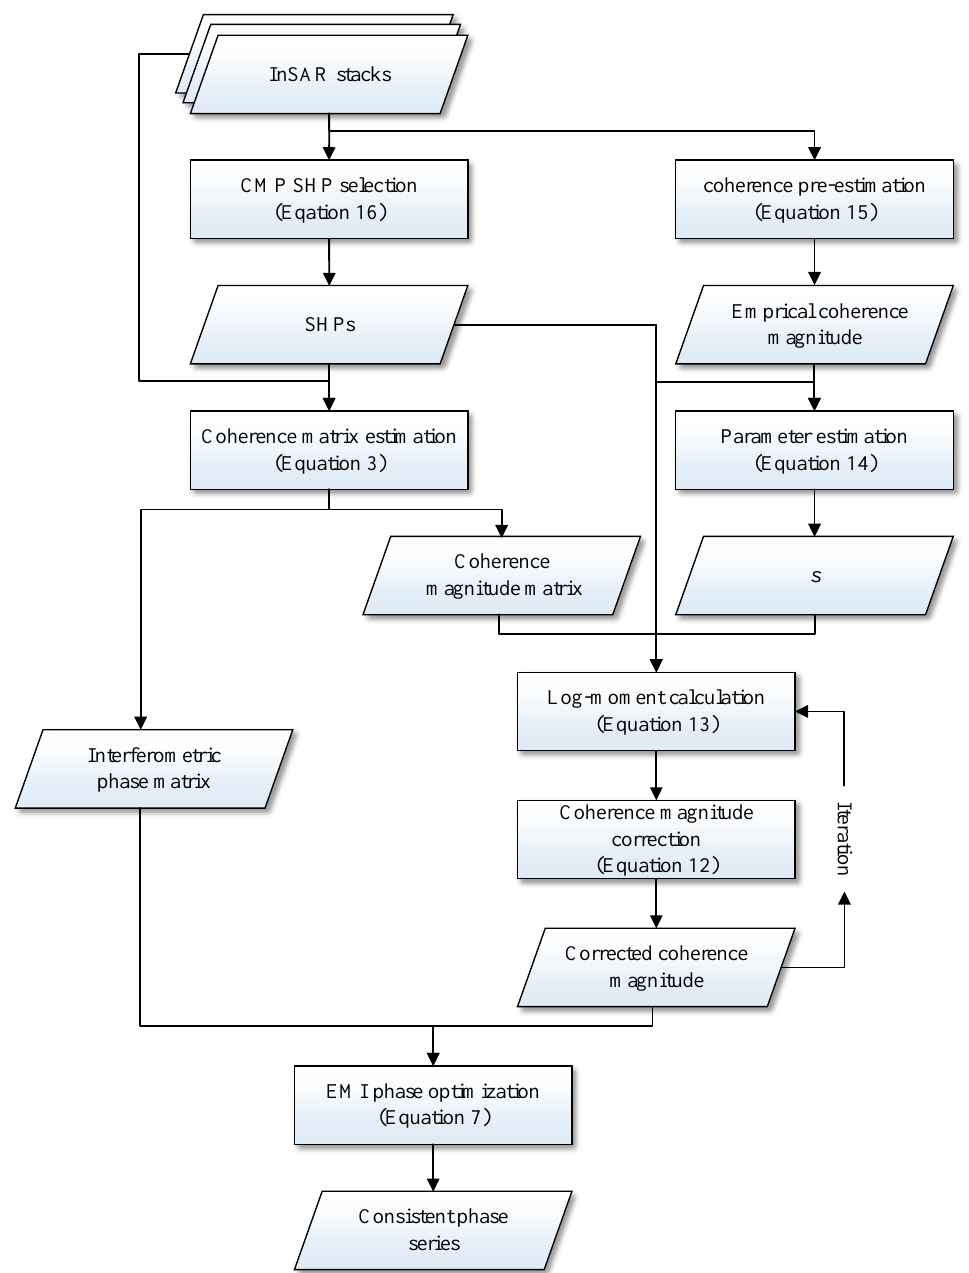
Figure 3. Flowchart of the proposed phase estimation